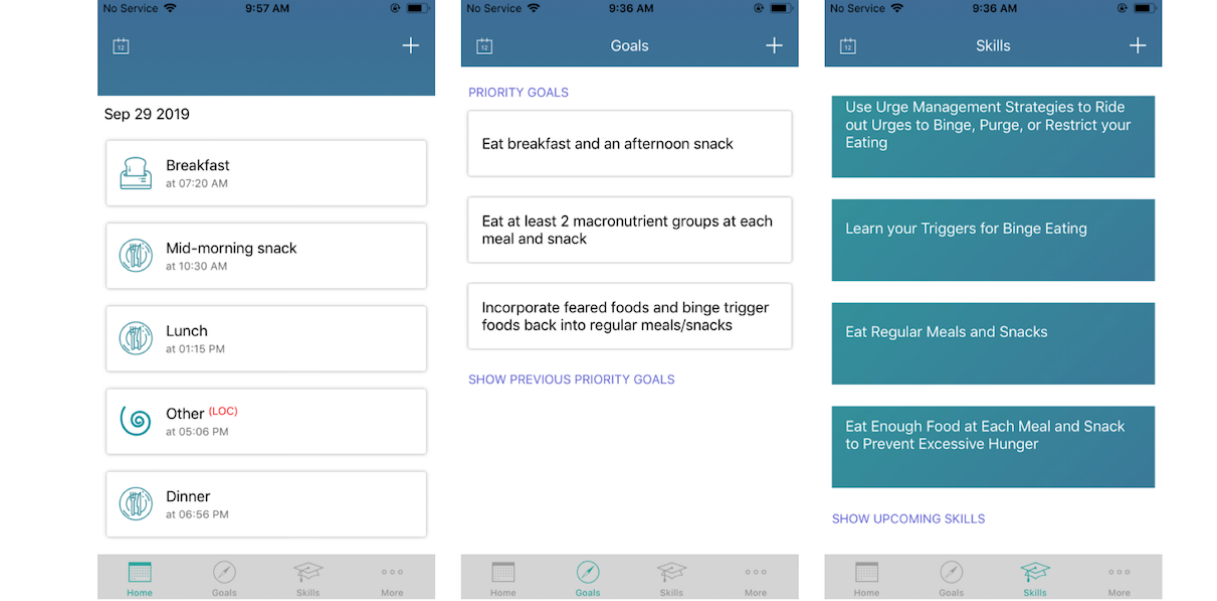
Figure 1. Screenshots of the home screen showing all the tabs CBT+ users can